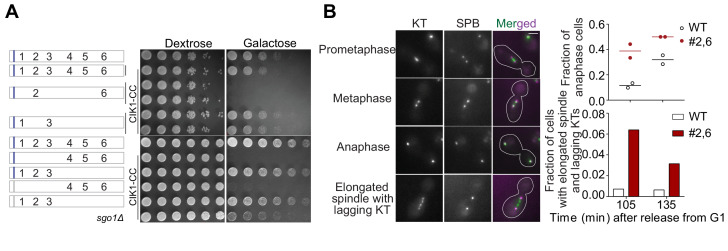
Multiple, strong MELT motifs per Spc105 are essential for cell survival when chromosome biorientation is challenged by conditionally disrupting the mitotic Cik1 functions.(A) Effect of Cik1-CC overexpression (stimulated by the use of galactose as the carbon source) on the indicated strains. (B) Micrographs on the left show the scoring scheme used to identify cells in anaphase and those with elongated spindles, which are indicative of anaphase onset (but cannot be confirmed as anaphase). Bar ~3.2 µm. Scatter and bar plots on the right show quantification. (n = 694 and 476 at 105 and 135 min respectively for WT and 547 and 317 at 105 and 135 min respectively for #2,6 from two repeats).Figure 2—figure supplement 2—source data 1.Data needed for the plots shown in Figure 2—figure supplement 2B top right and 2B bottom right.